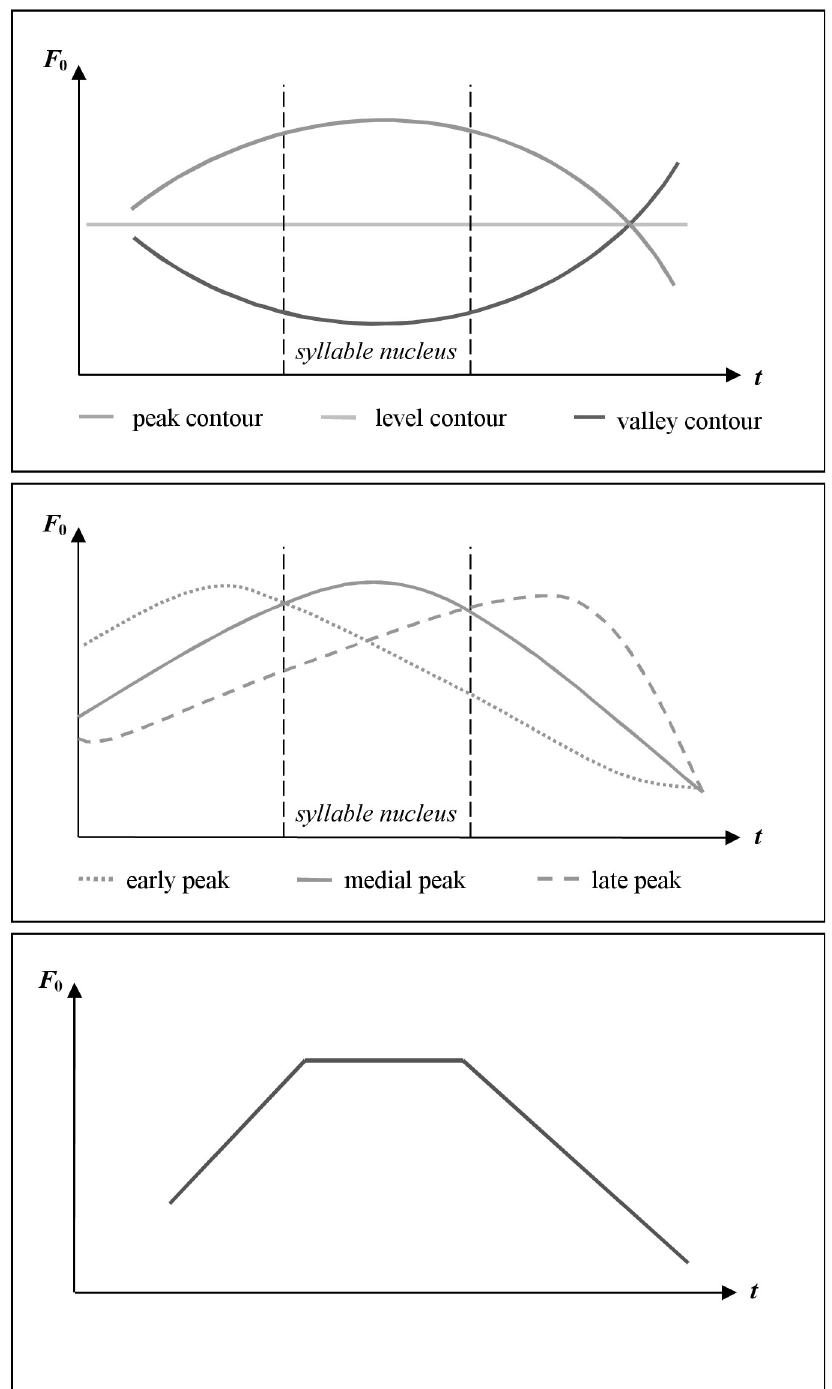
Fig 1. Schematic overview of F 0 fundamental frequency